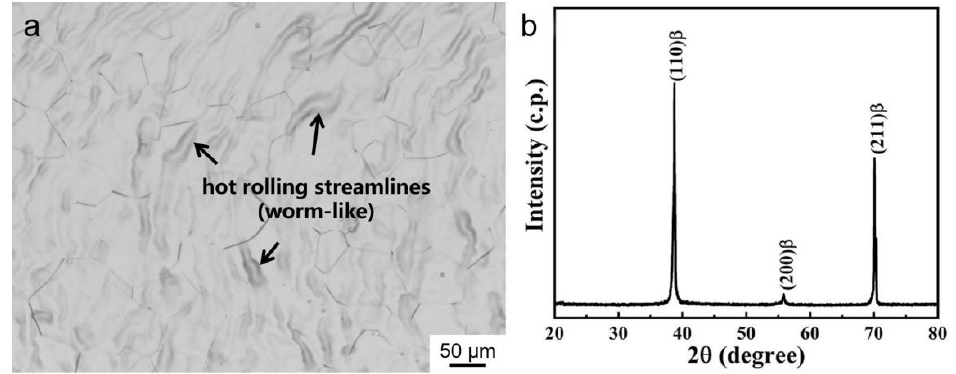
Figure 2. The β -solution-treated microstructure ( a ) and XRD pattern ( b ) of Ti-B12 alloy before isothermal deformation test.